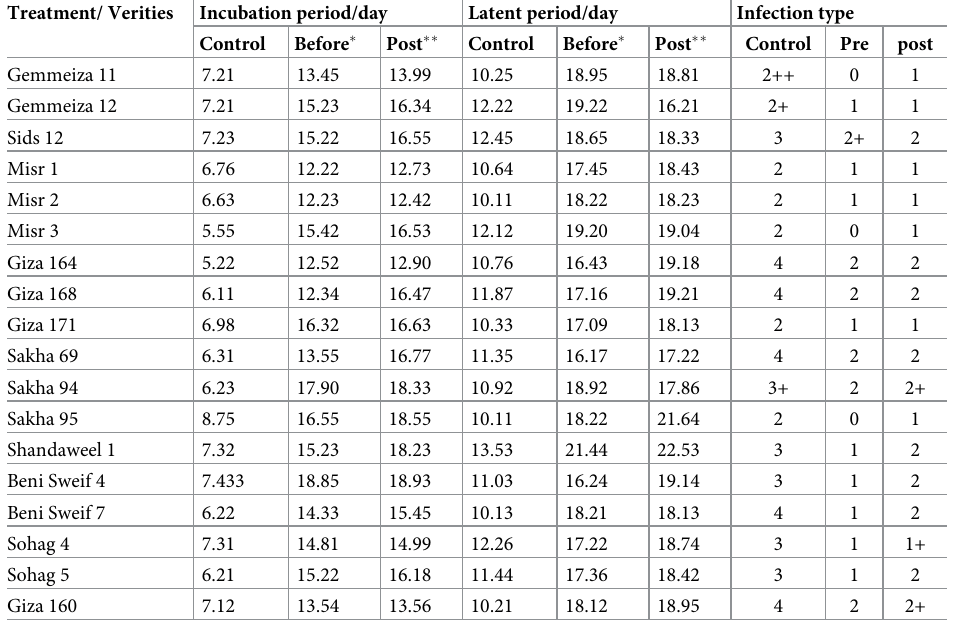
Table 10. Effect of Cu-chitosan NPs treatments and application methods on incubation, latent periods and infec- tion type of the wheat leaf rust disease. Treatment/